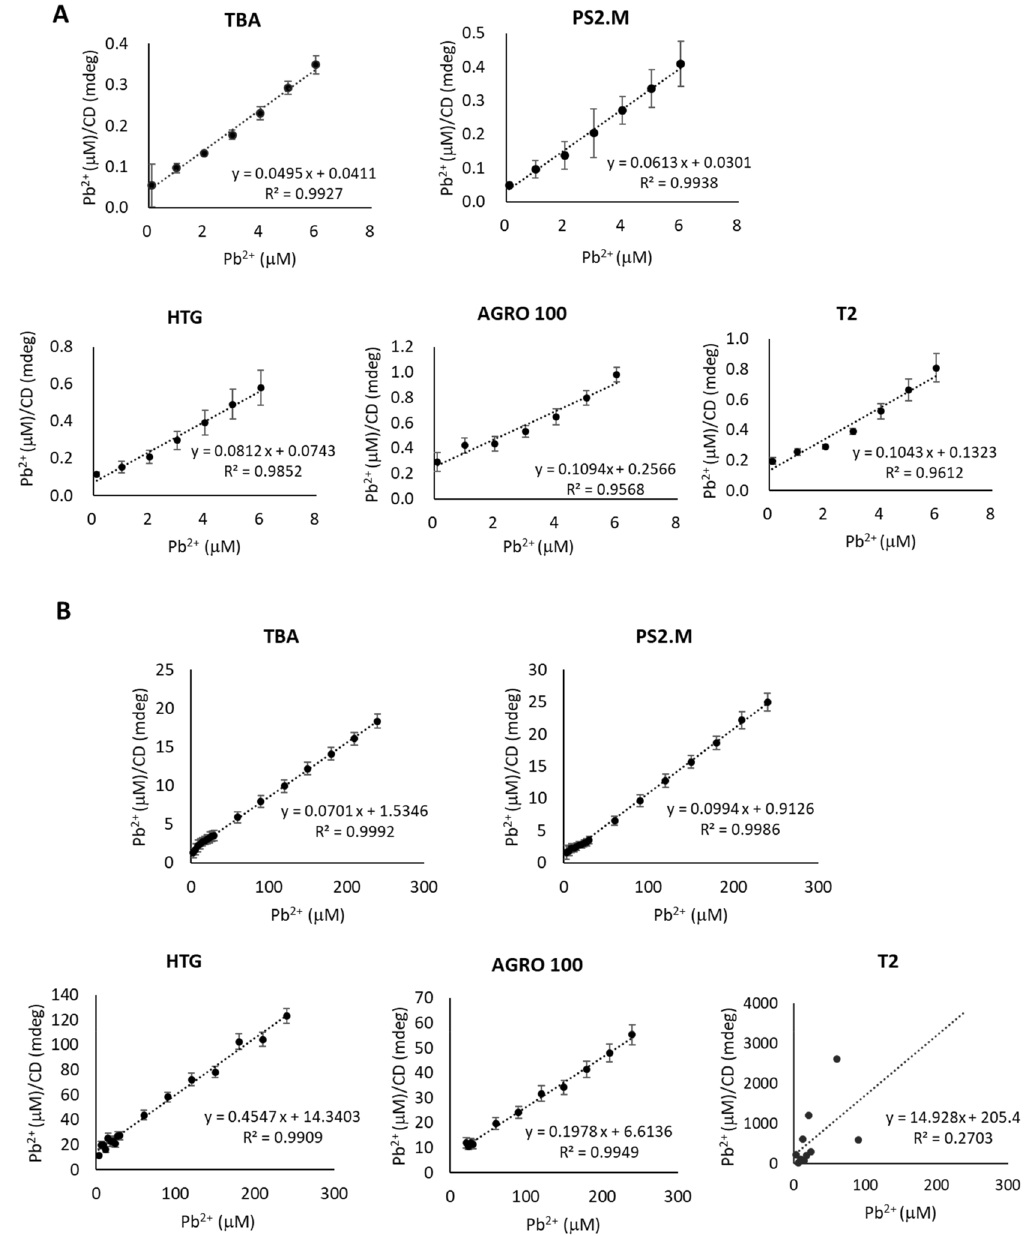
concentration. ( B ) Association relationship for each G-QD at 100 mM K + concentration. c, Pb concentration; q, CD absorption